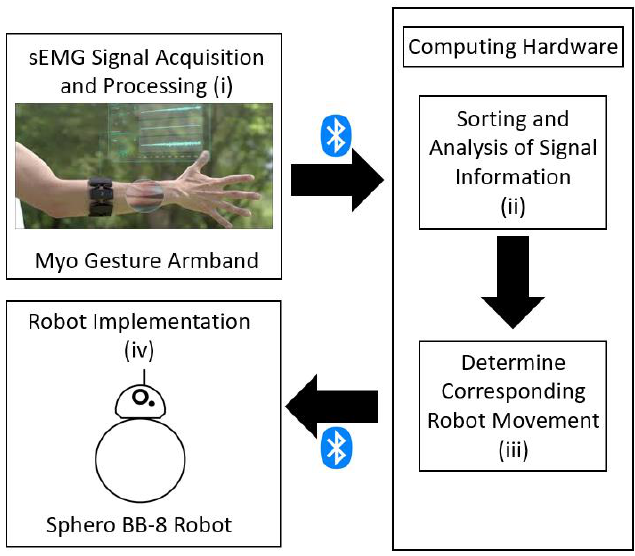
Figure 2. The system architecture (i.e. Experimental